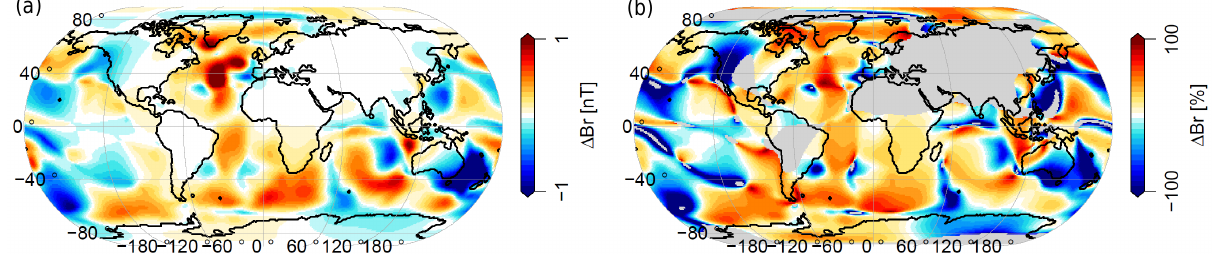
Figure 1. Differences in radial tidal magnetic field at satellite height. STORMTIDE minus OMCT amplitudes, i.e., two forward models. (a) Absolute differences. (b) Relative differences (regions of tidal signal strength below 0.1nT are grayed